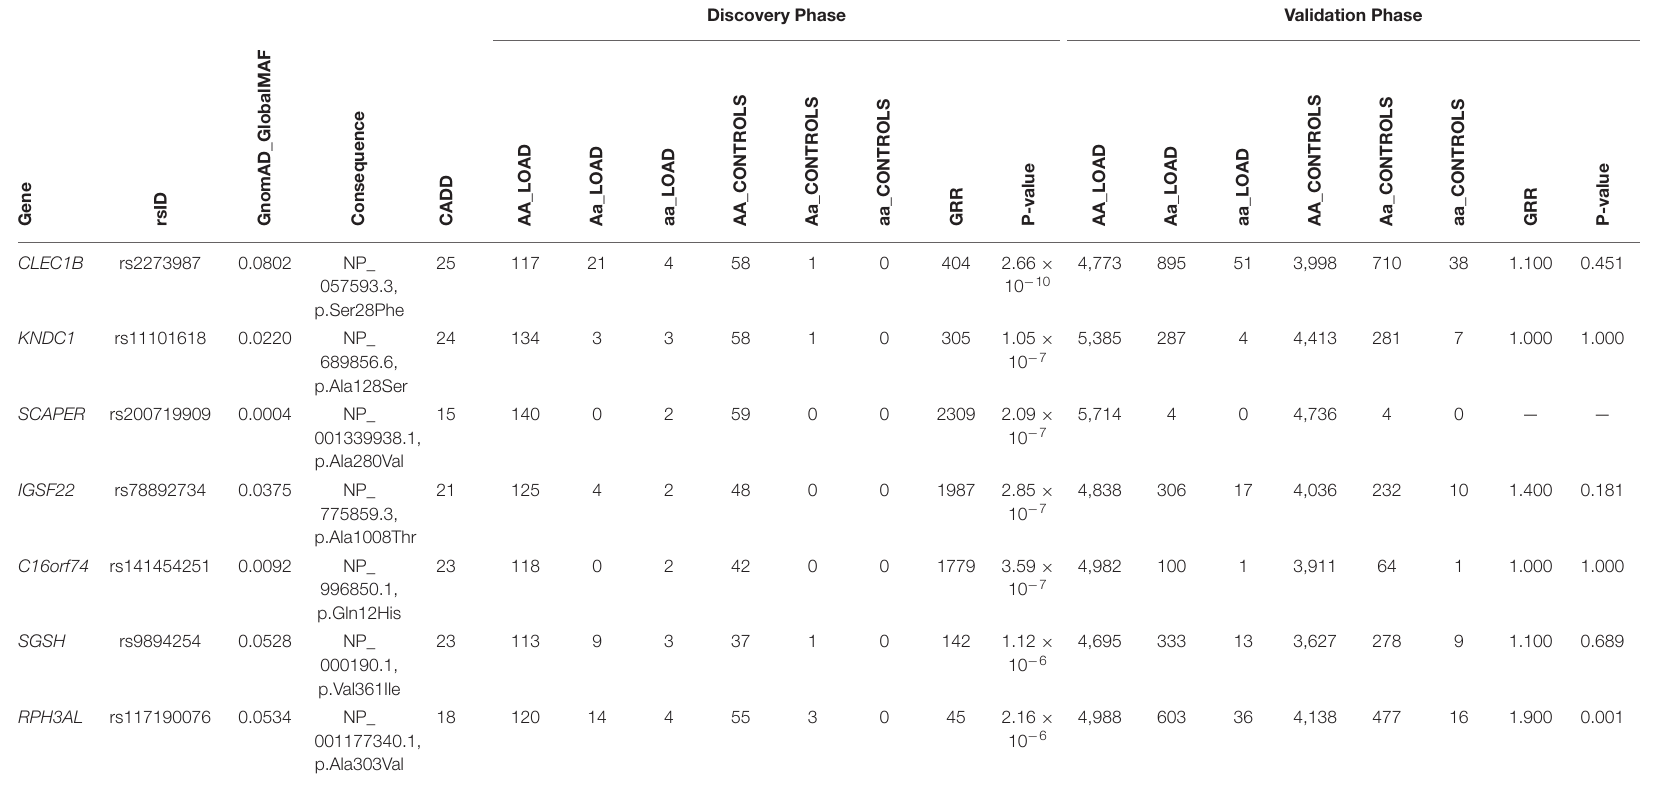
TABLE 5 | Identification of RPH3AL rs117190076 as rare, deleterious minor homozygote variant associated with LOAD. Discovery Phase Validation